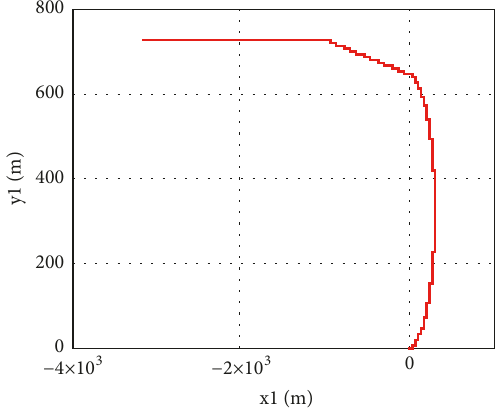
Figure 14: Vessel trajectory during rotation towards the return course for values 𝑧 ∗ 3 = 0.005𝑟𝑎𝑑 ⋅ 𝑠 −1 , 𝑧 ∗ 6 = 3.4𝑟𝑎𝑑 ; 𝑇 𝑢 = 0.1𝑠 , 𝐹 = 10 , 𝐹 = 0.01 , 𝑧 ∗ = 0.01 sign (𝑧 ∗ ) . 6 7 7 6